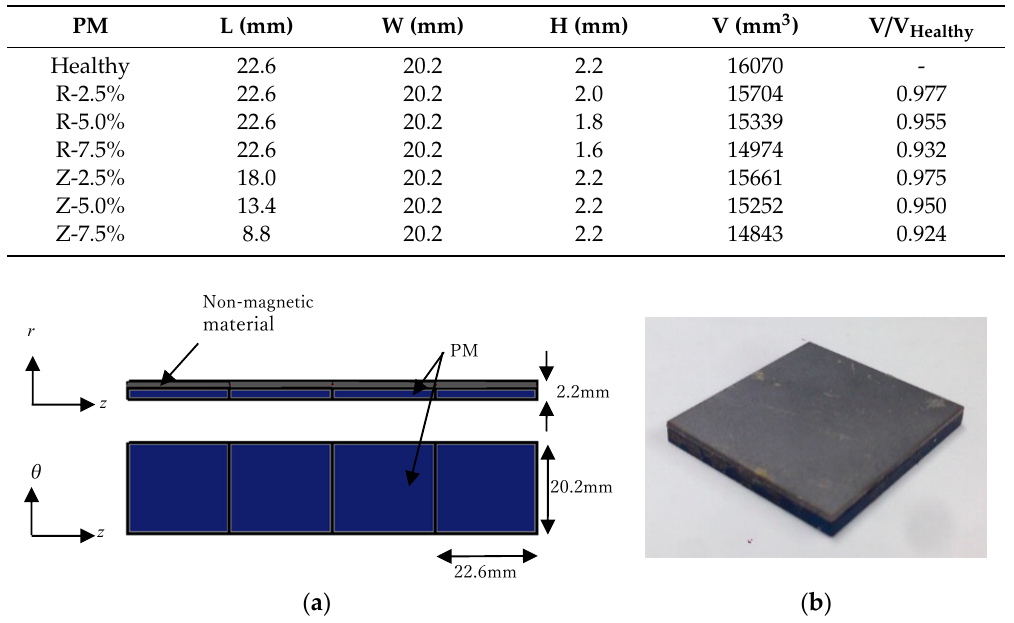
Table 1. Dimensions of PMs.